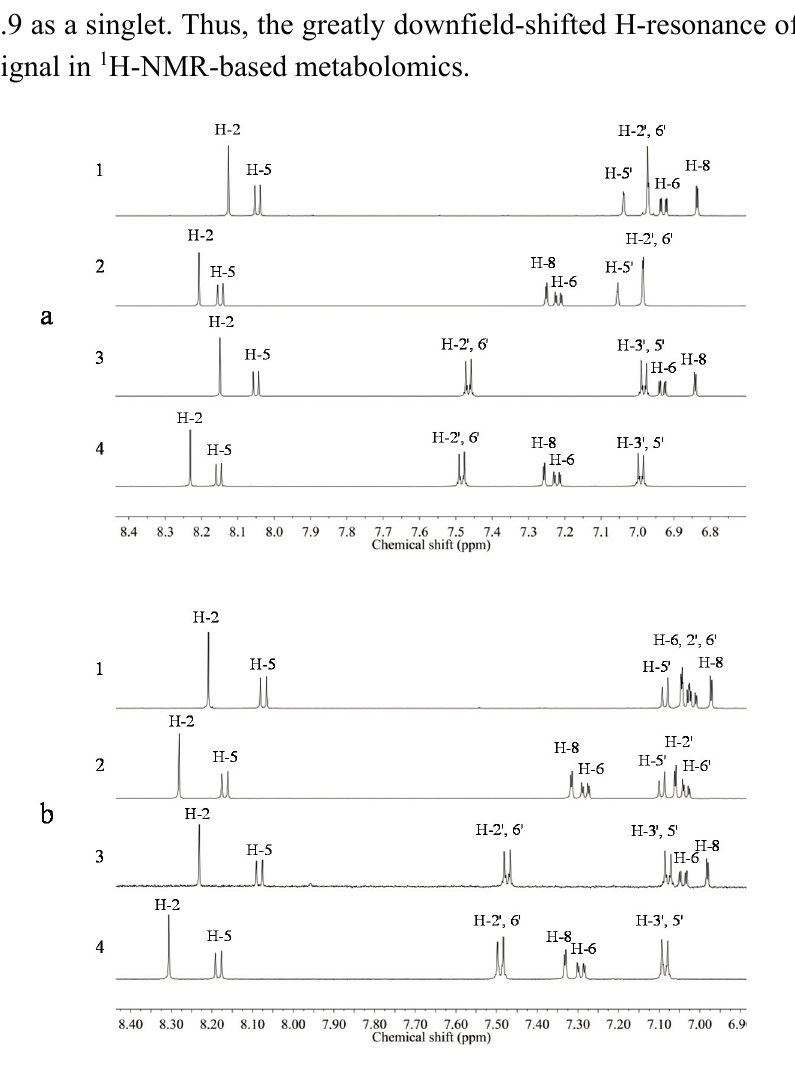
Figure 3. 1 H-NMR spectra of calycosin (1), calycosin-7- O -glucoside (2), formononetin (3), and formononetin- O -glucoside (ononin, 4). ( a ) In CD 3 OD; ( b ) CD 3 OD-KH 2 PO 4 buffer in D 2 O (1:1,